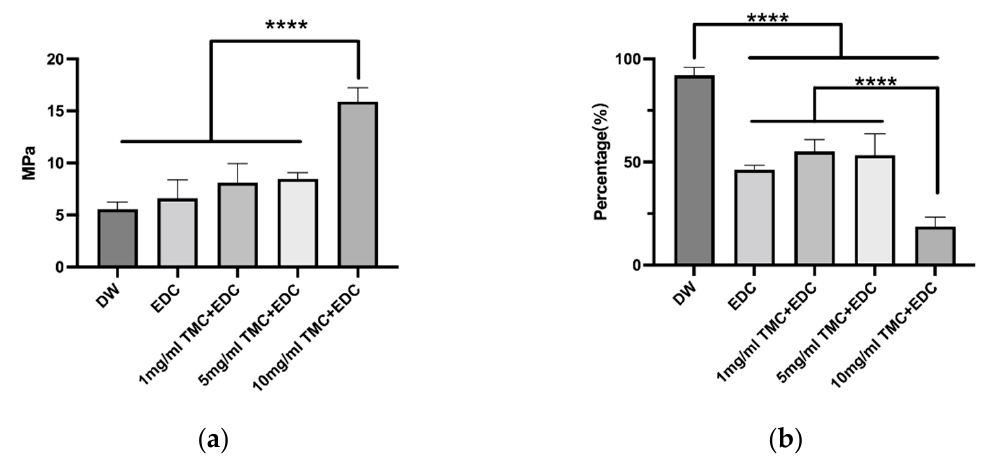
Figure 5. ( a ) Elastic modulus of each group after different treatment methods; ( b ) Degradation percentage of elastic modulus after collagenase degradation. (****, p < 0.0001.)